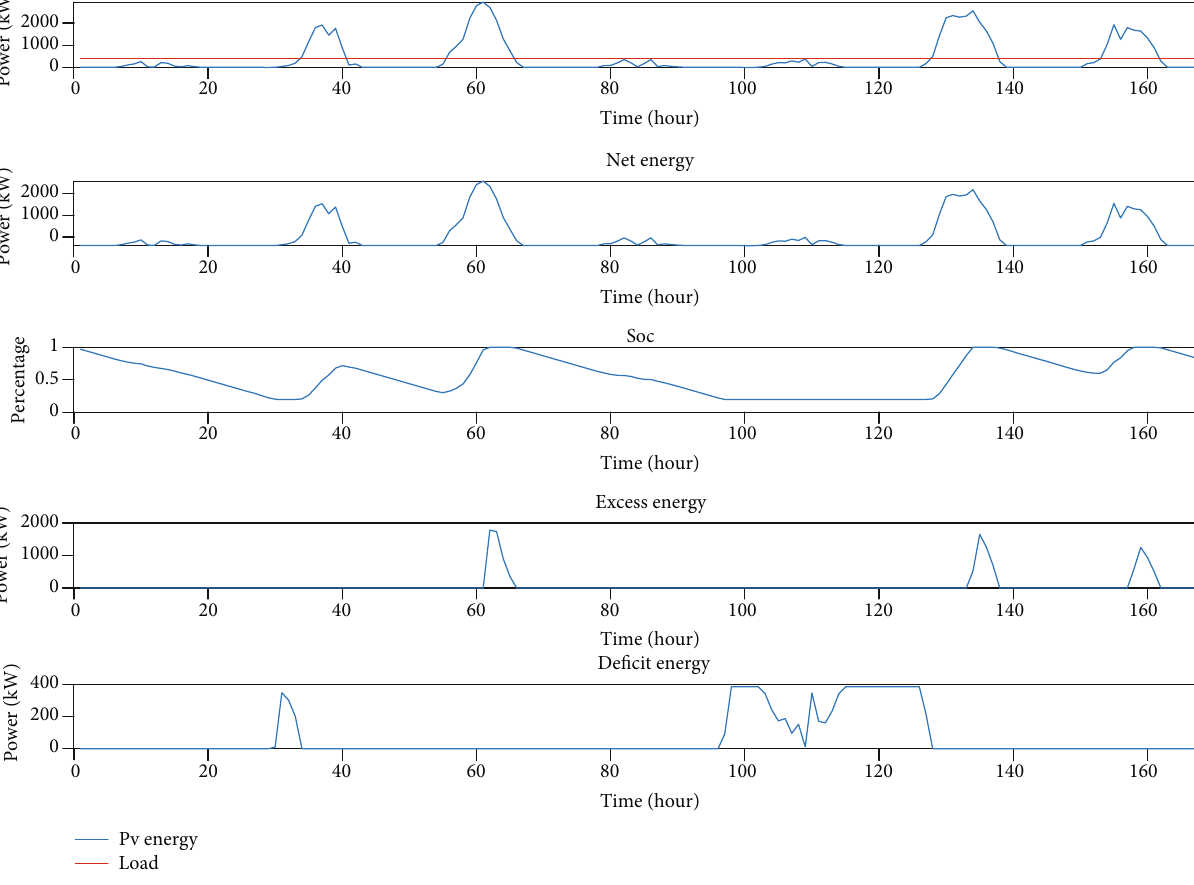
Figure 15: System performance sample for the second scenario: Ramallah station.